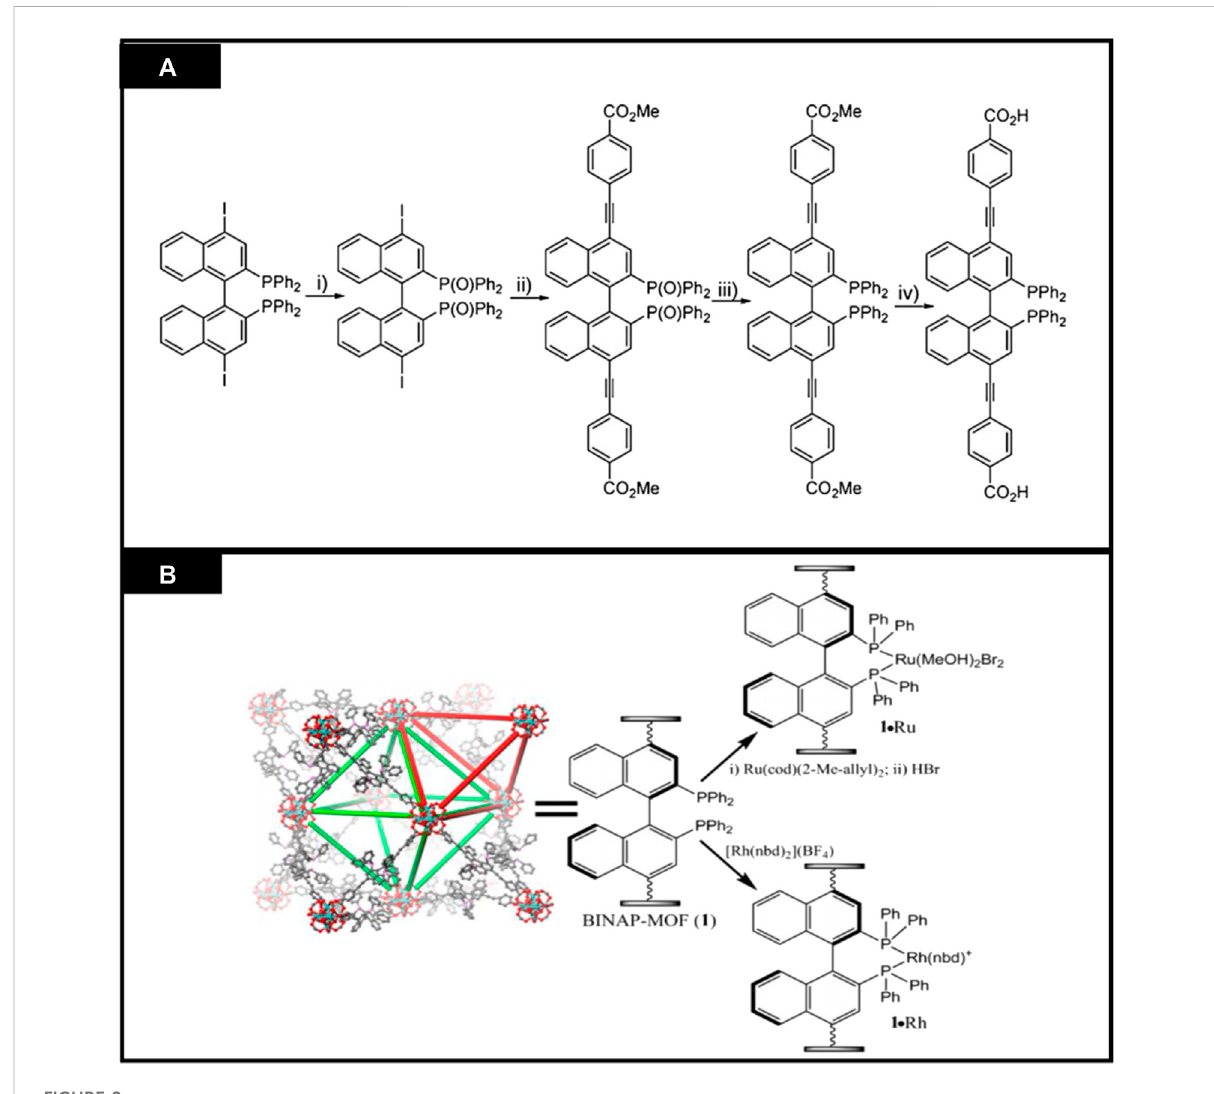
FIGURE 8 (A) Synthesisofa2,2 ′ -bis(diphenylphosphino)-1,1 ′ -binaphthyl(BINAP)deriveddicarboxylicacidligand (B) Postmodi fi cationofBINAP-MOFwith metals. [Reproduced with permission from Falkowski et al.